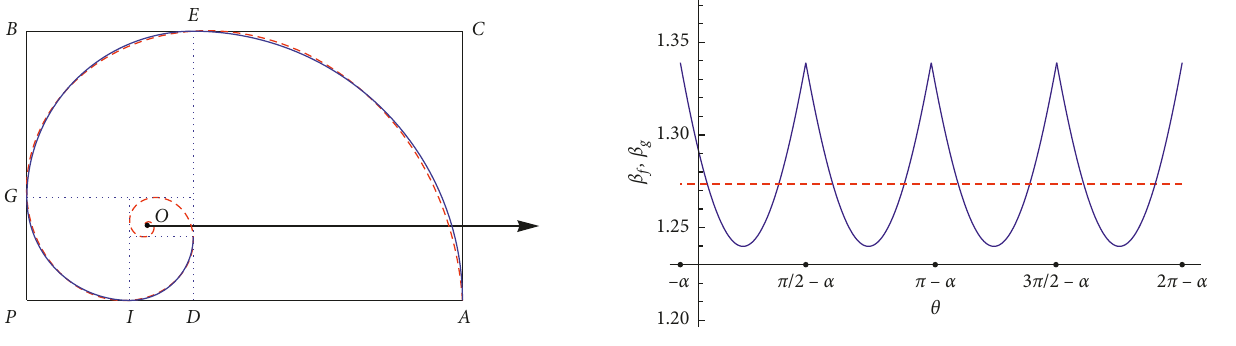
Figure 9: Arm-radius angles for the Fibonacci spiral (solid line) and golden spiral (dashed line).